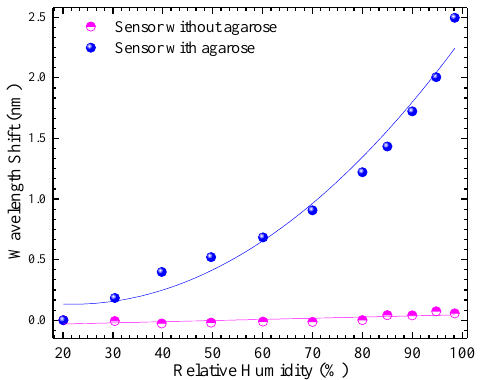
Figure 6. Measured wavelength shift dependence with relative humidity (RH), considering both sensors.